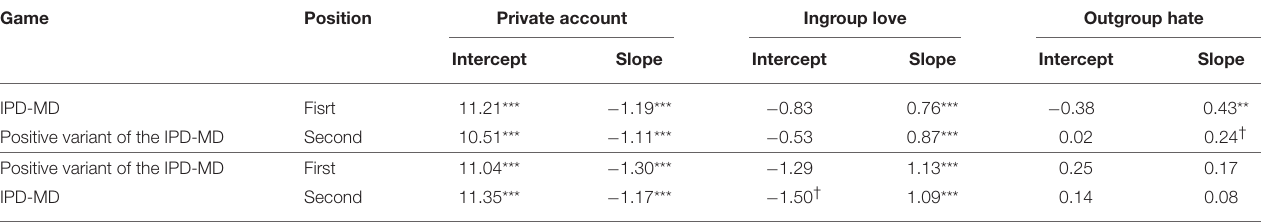
TABLE 4 | Generalized linear mixed effects